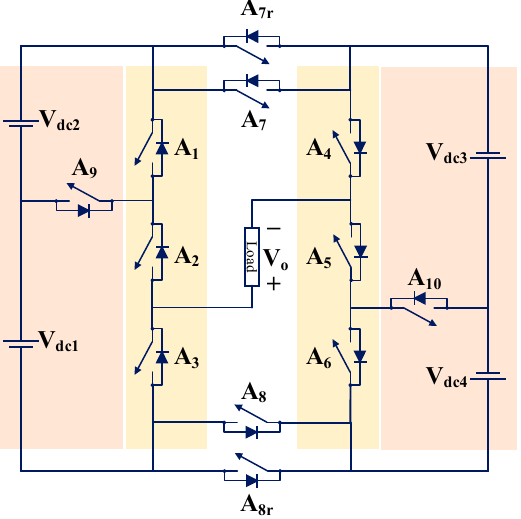
Figure 23. Single-phase FT MLI (symmetric configuration = TP24; asymmetric configuration = TP25) [42].